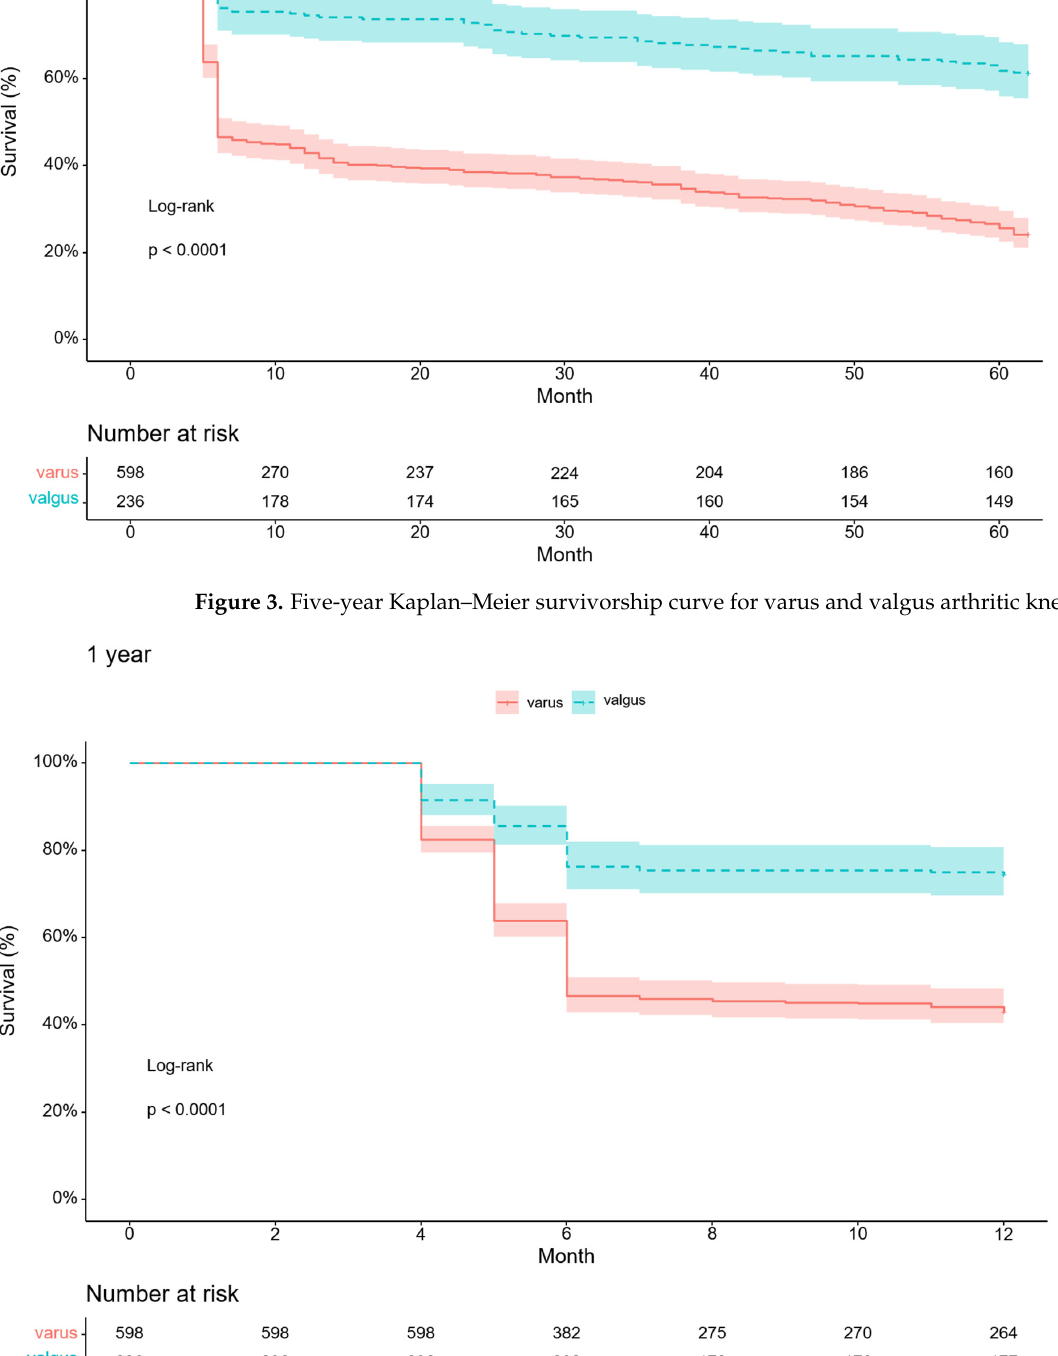
Figure 5. ROC curve for TKA of varus and valgus arthritic knees using the HKA. ROC, receiver operating characteristic; TKA, total knee arthroplasty; AUC, area under the ROC curve; HKA, hip– knee–ankle angle.